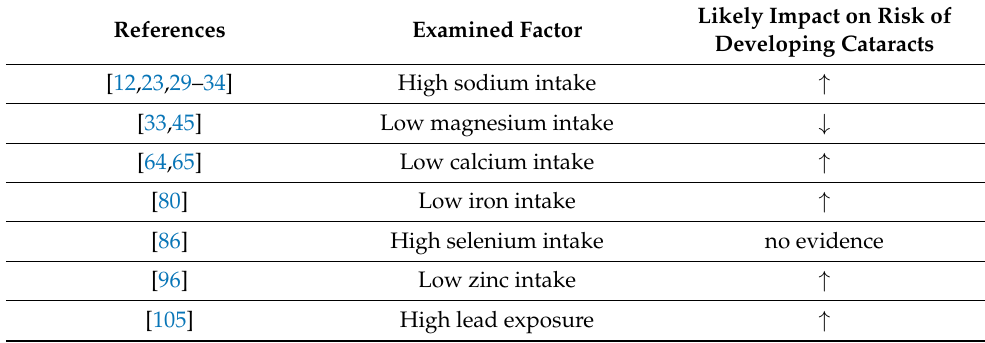
Table 1. Intake/exposure of selected trace elements and associated risk of developing